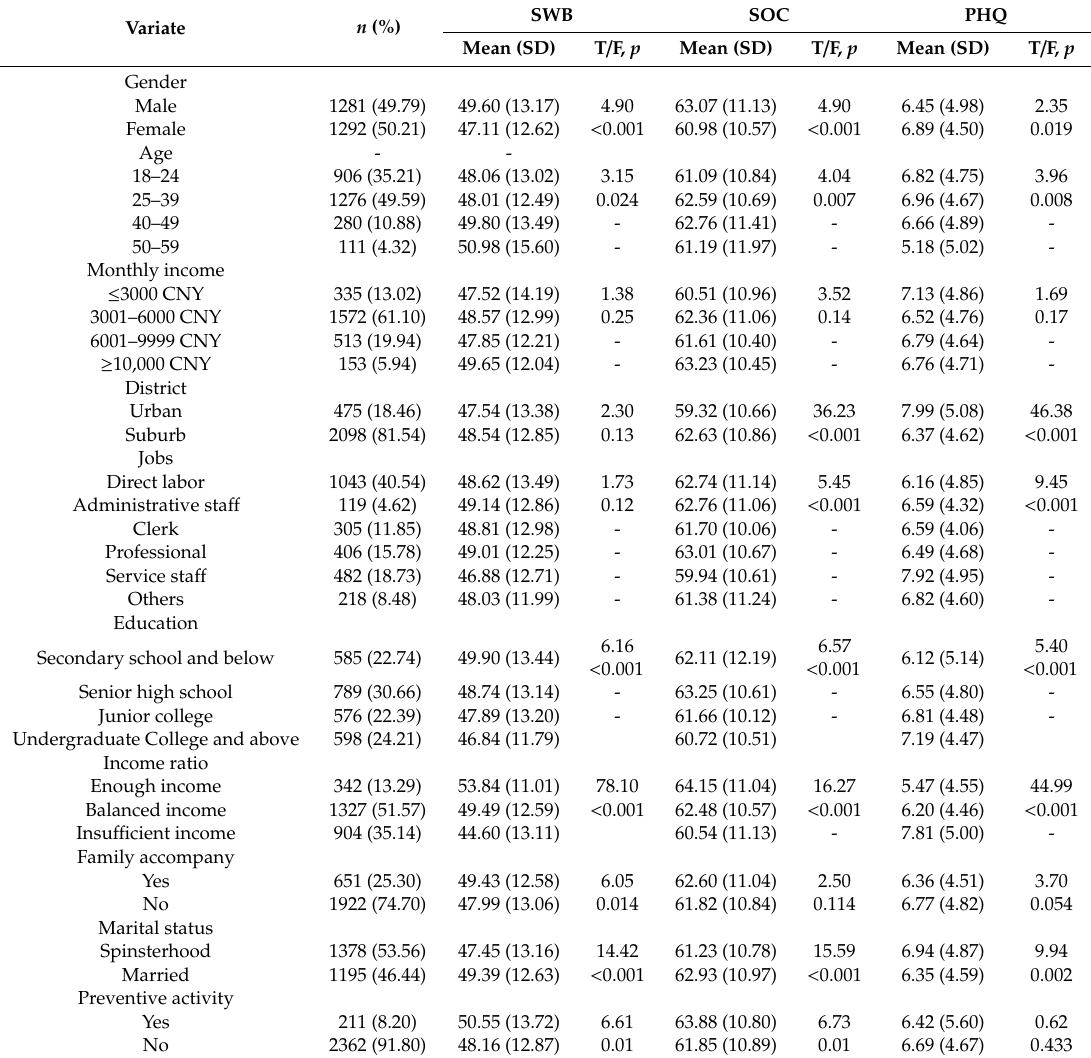
Table 1. The specific associations among demographic characteristics and SWB, SOC, and PHQ. Variate Gender